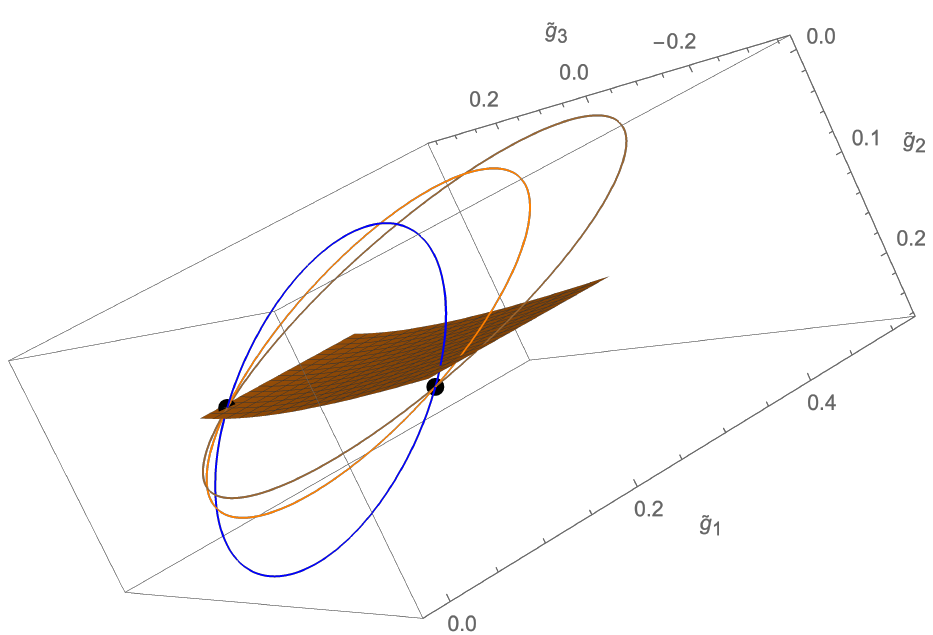
= 1 / 2 (blue), x = 1 / 3 (orange) and 1 1 = ˜ g = 1 / 8, ˜ g = ± 1 / 4 which are 1 2 3 = 1 / 3, intersects the orange curve at 1 ) which are two theories with m / N = 1 / 3, 3 = 1 / 4 has the global symmetry 3 = − 1 / 4 at finite temperatures 3